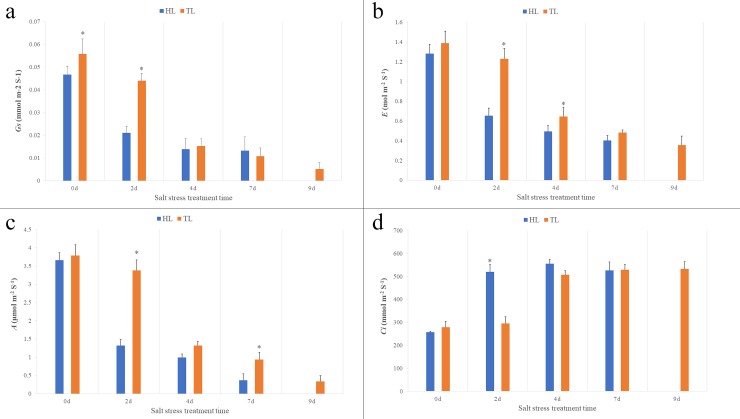
Photosynthetic gas exchange in different salt stress treatment time.a: Stomatal conductance (Gs), b: Transpiration rate (E), c: Photosynthetic rate (A), d: Internal CO2 concentration (Ci). The values are means +SD (Standard Deviation) (n = 5). The asterisk indicates a significant difference (p<0.05).